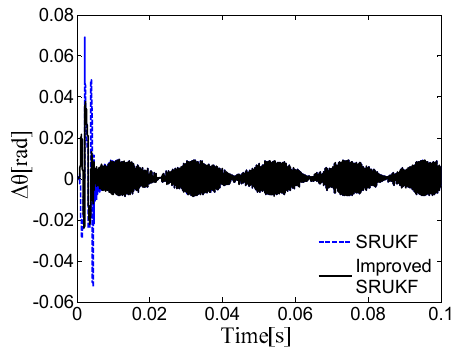
Figure 4. Space position estimation error at 50 rad/s.